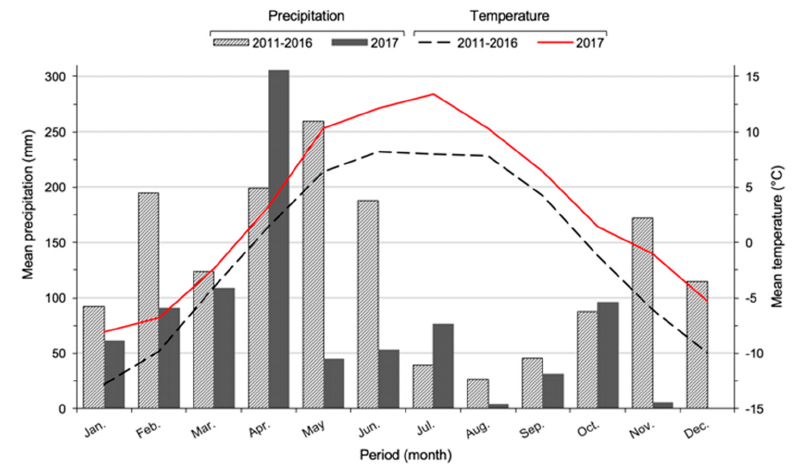
Figure 13. Comparison of precipitation and temperature for the year 2017 (dark gray) versus precipitation and temperature for a period from 2011 to 2016 (hatched) based on in situ data from the Ak ‐ Terek station (located at a higher altitude than the Mailuu ‐ Suu River slopes, at about 1800 m, where the temperature is about 4° C lower than in the Mailuu ‐ Suu region).